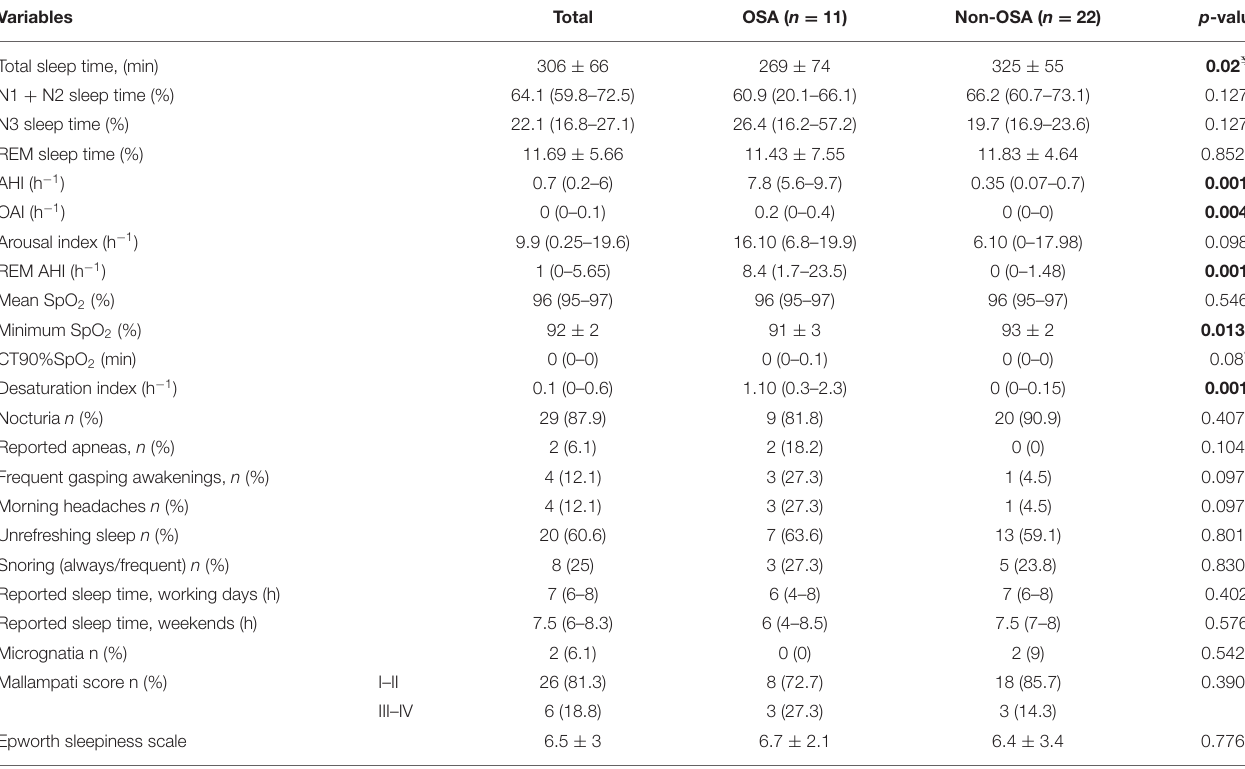
TABLE 2 | Polysomnography data, sleep symptoms, and physical characteristics in OSA and non-OSA groups. Variables